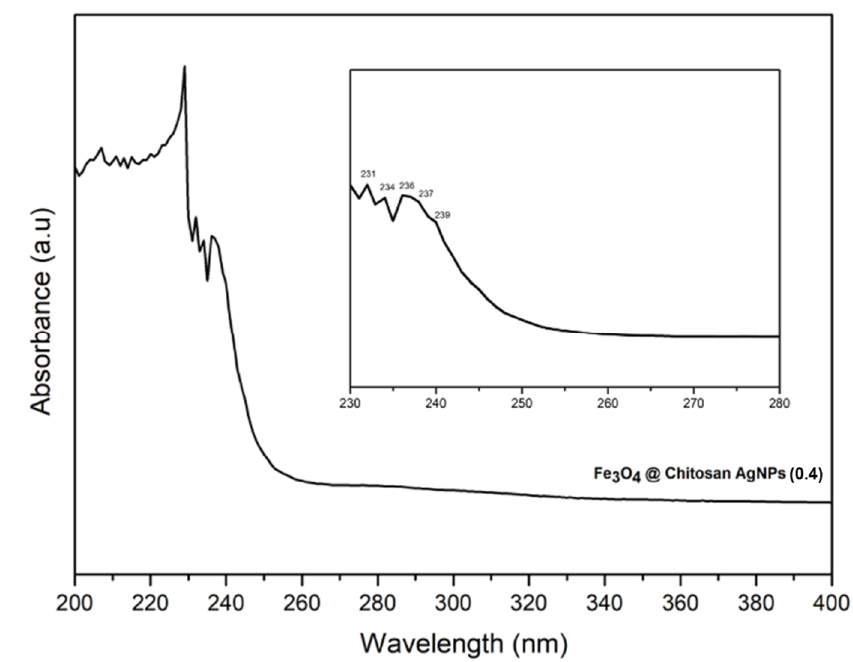
Figure 4. UV-visible spectra of Fe 3 O 4 @Chitosan-AgNP